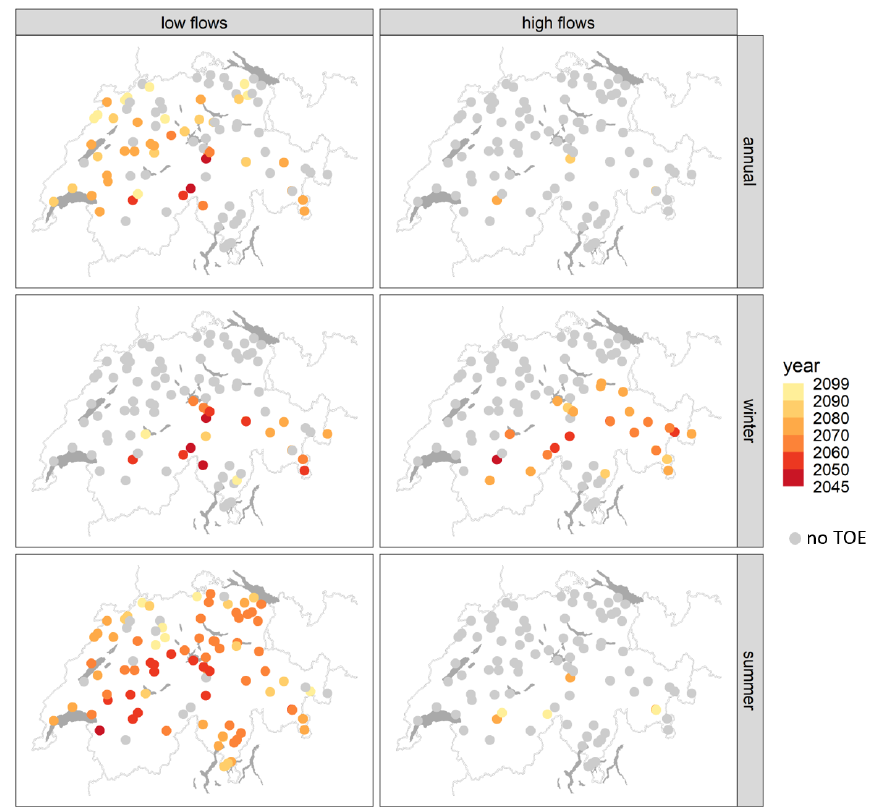
Figure 6. Time of emergence of moderate low flows (left panels) and moderate high flows (right panels) when at least 66% of the models agree on significant changes in the distribution of moderate low and high